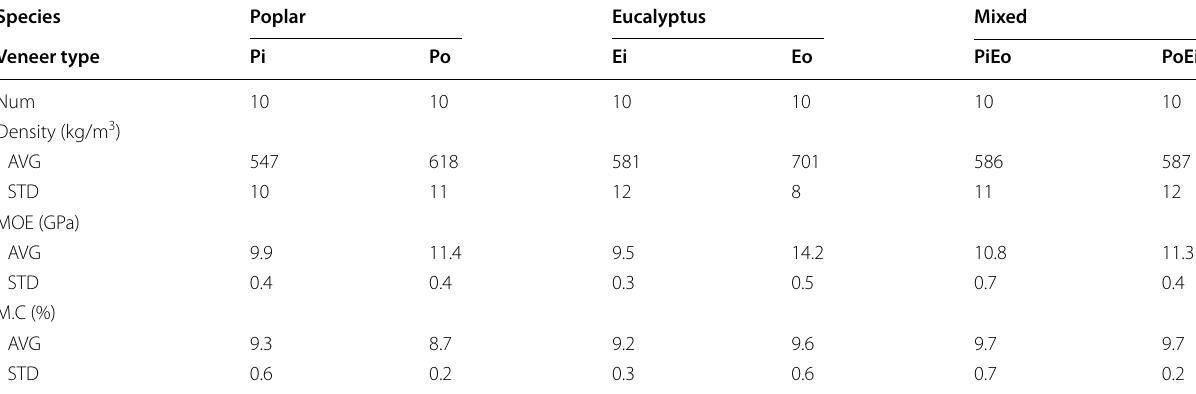
MOE modulus of elasticity, AVG average value, STD standard diviation